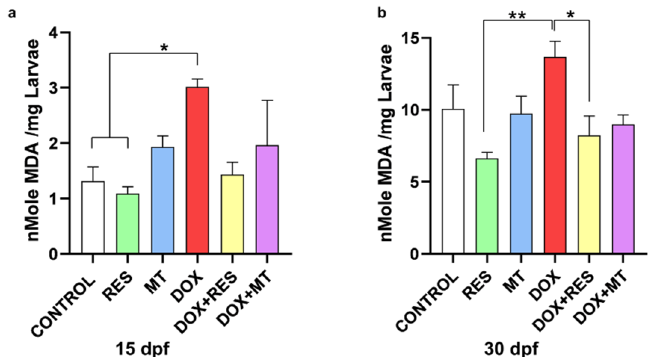
Figure 6. Lipid peroxidation on zebrafish fed microdiets enriched with antioxidants, resveratrol (RES) and MitoTEMPO (MT), and pro-oxidant, doxorubicin (DOX). Lipid peroxidation of the zebrafish larvae at 15 dpf ( a ) and 30 dpf ( b ). Levels of significance were calculated using Tukey’s multiple comparisons (one-way ANOVA) [* p ≤ 0.05 and ** p ≤